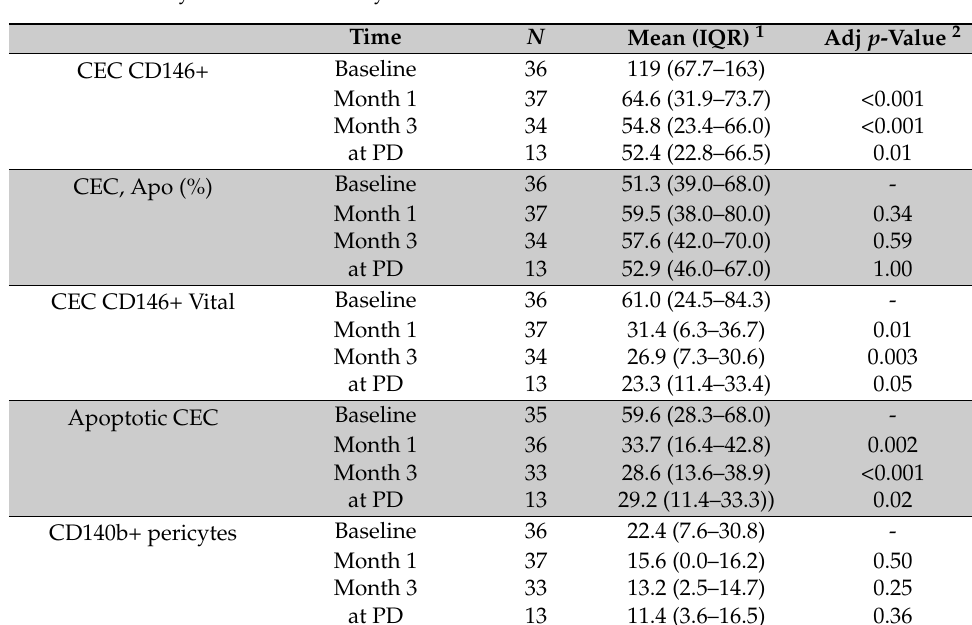
Figure 1. Serum BAT concentration by time from Everolimus start. Serum concentration units: TPS1 (ng/mL) × 100; VEGF (pg/mL) × 100; VEGFR2 (pg/mL) × 100; bFGF (pg/mL). Table 2. Summary Statistics of CCs by time from everolimus